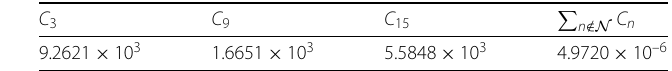
Table 2 Relevant and irrelevant Fourier modes of the Lagrange multipliers of an IGA simulation result for α = 7 ° , C n